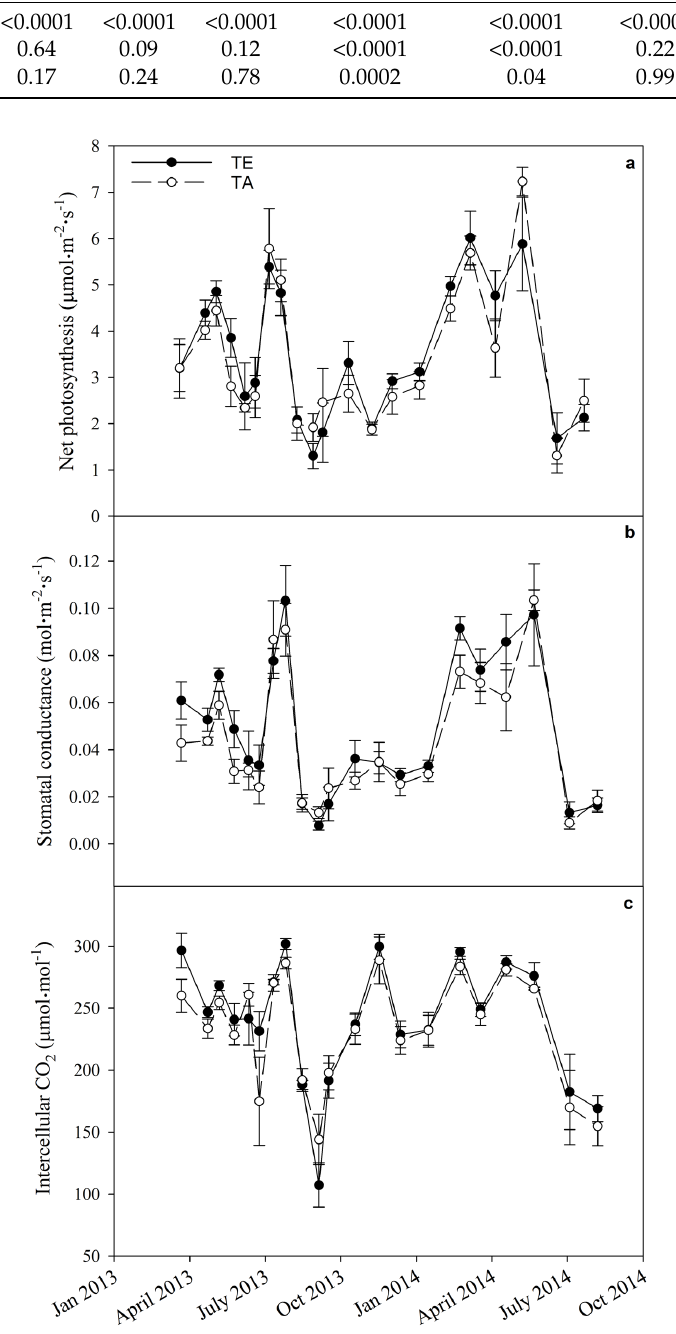
Figure 6. ( a ) Mean leaf ‐ level net photosynthesis; ( b ) mean stomatal conductance; ( c ) intercellular CO2 in response to 100% throughfall exclusion (TE) and ambient throughfall (TA) treatments. Error bars represent standard error of treatment means ( n = 5).